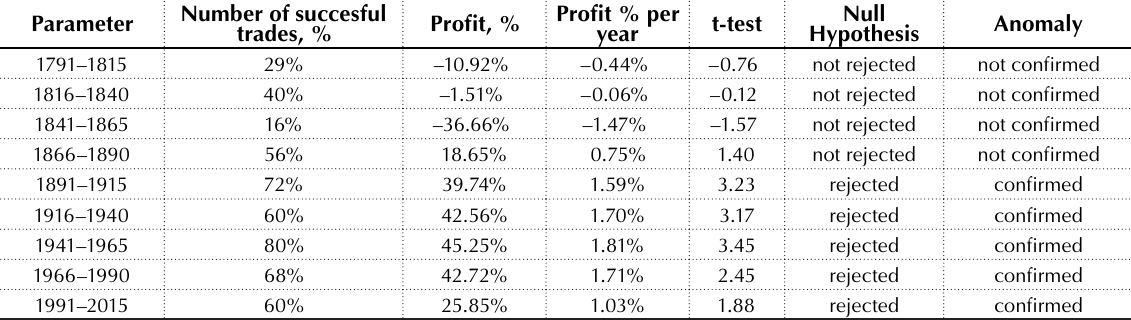
Table D 1. Trading simulation results of the January Effect for the US stock market during